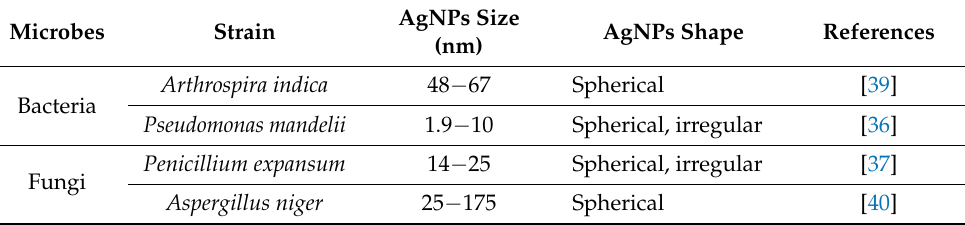
Table 1. AgNPs synthesized from various bacteria and fungi species. Microbes Strain